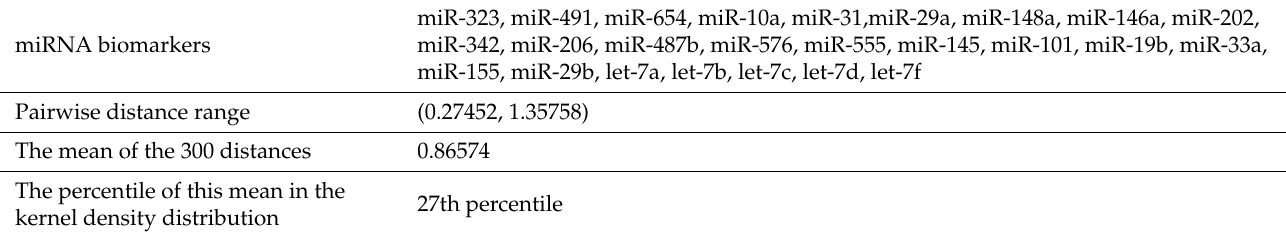
Table 2. The pairwise distance analysis of 25 miRNA biomarkers of anti-NMDA receptor encephalitis and